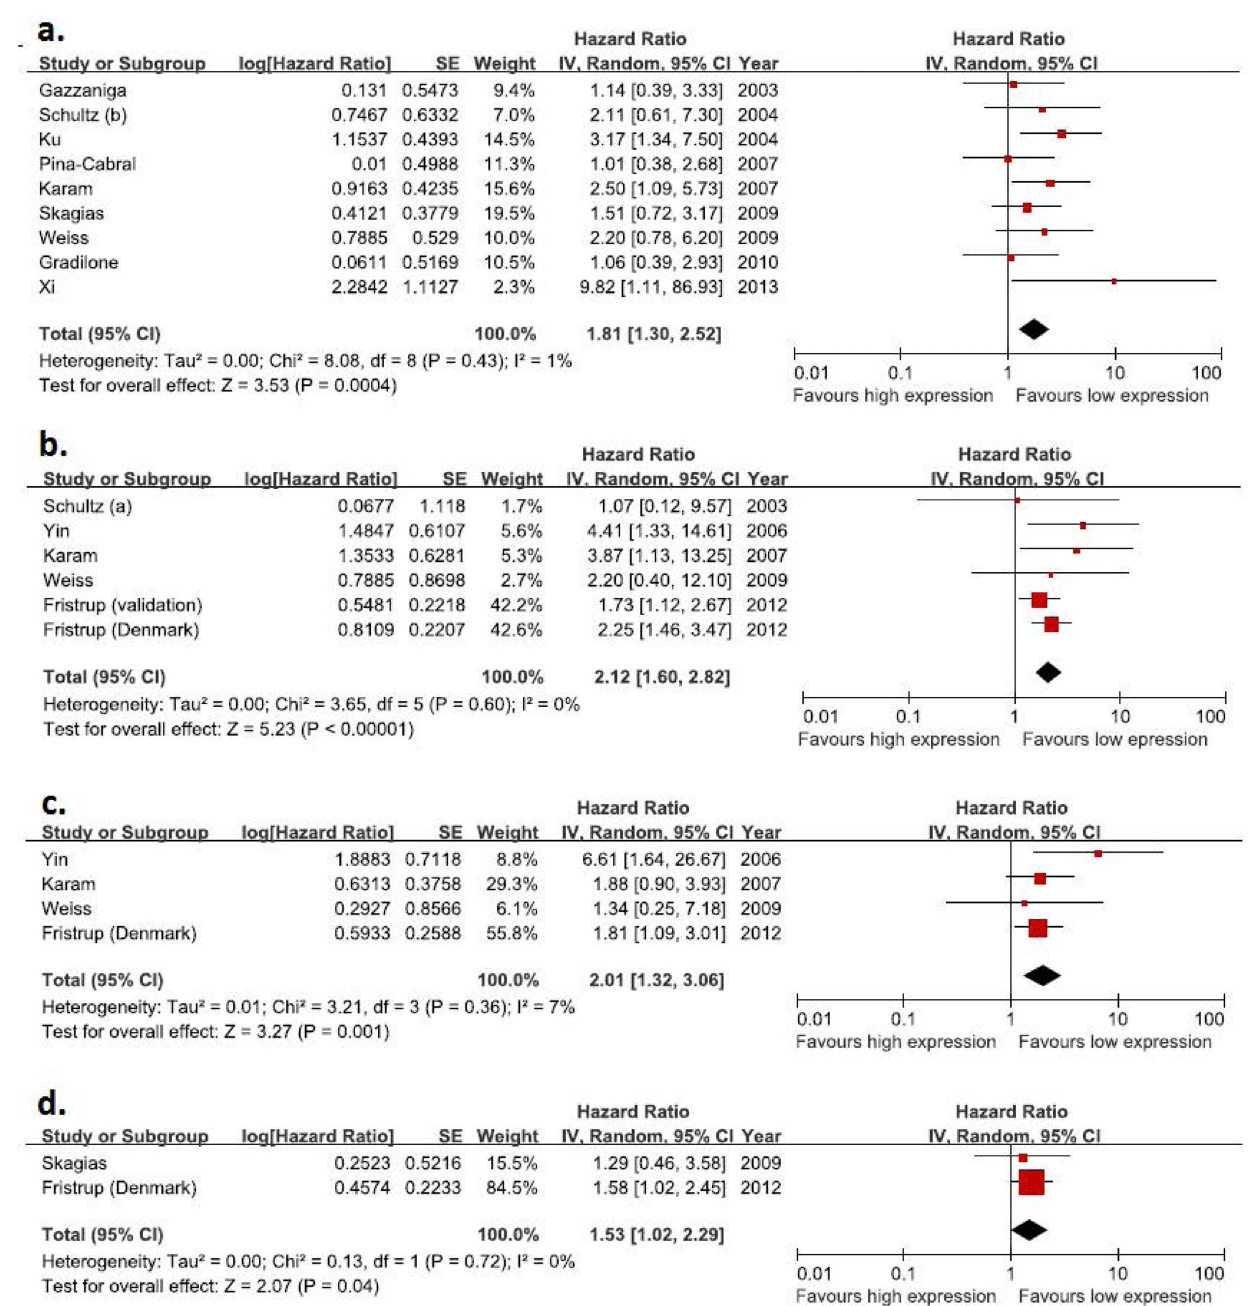
Figure 2. Forest plots of hazard ratios with random effects model for survivin in patients with non-muscle invasive bladder tumor. (A) Recurrence-free survival. (B) Progression-free survival. (C) Cancer-specific survival. (D) Overall